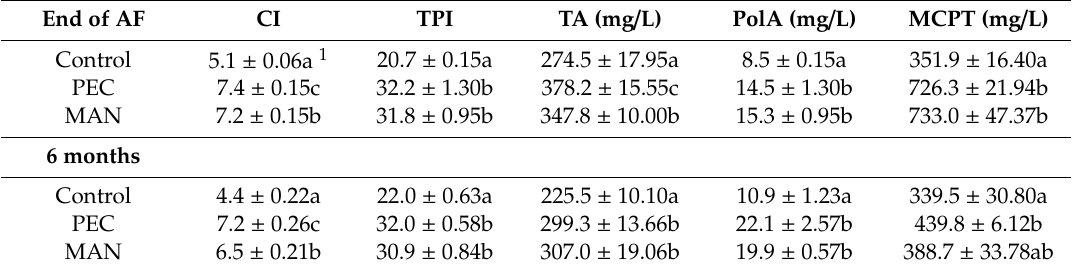
Table 6. Results of the chromatic analysis of wines treated with soluble polysaccharides at the end of alcoholic fermentation and after six months of aging in the